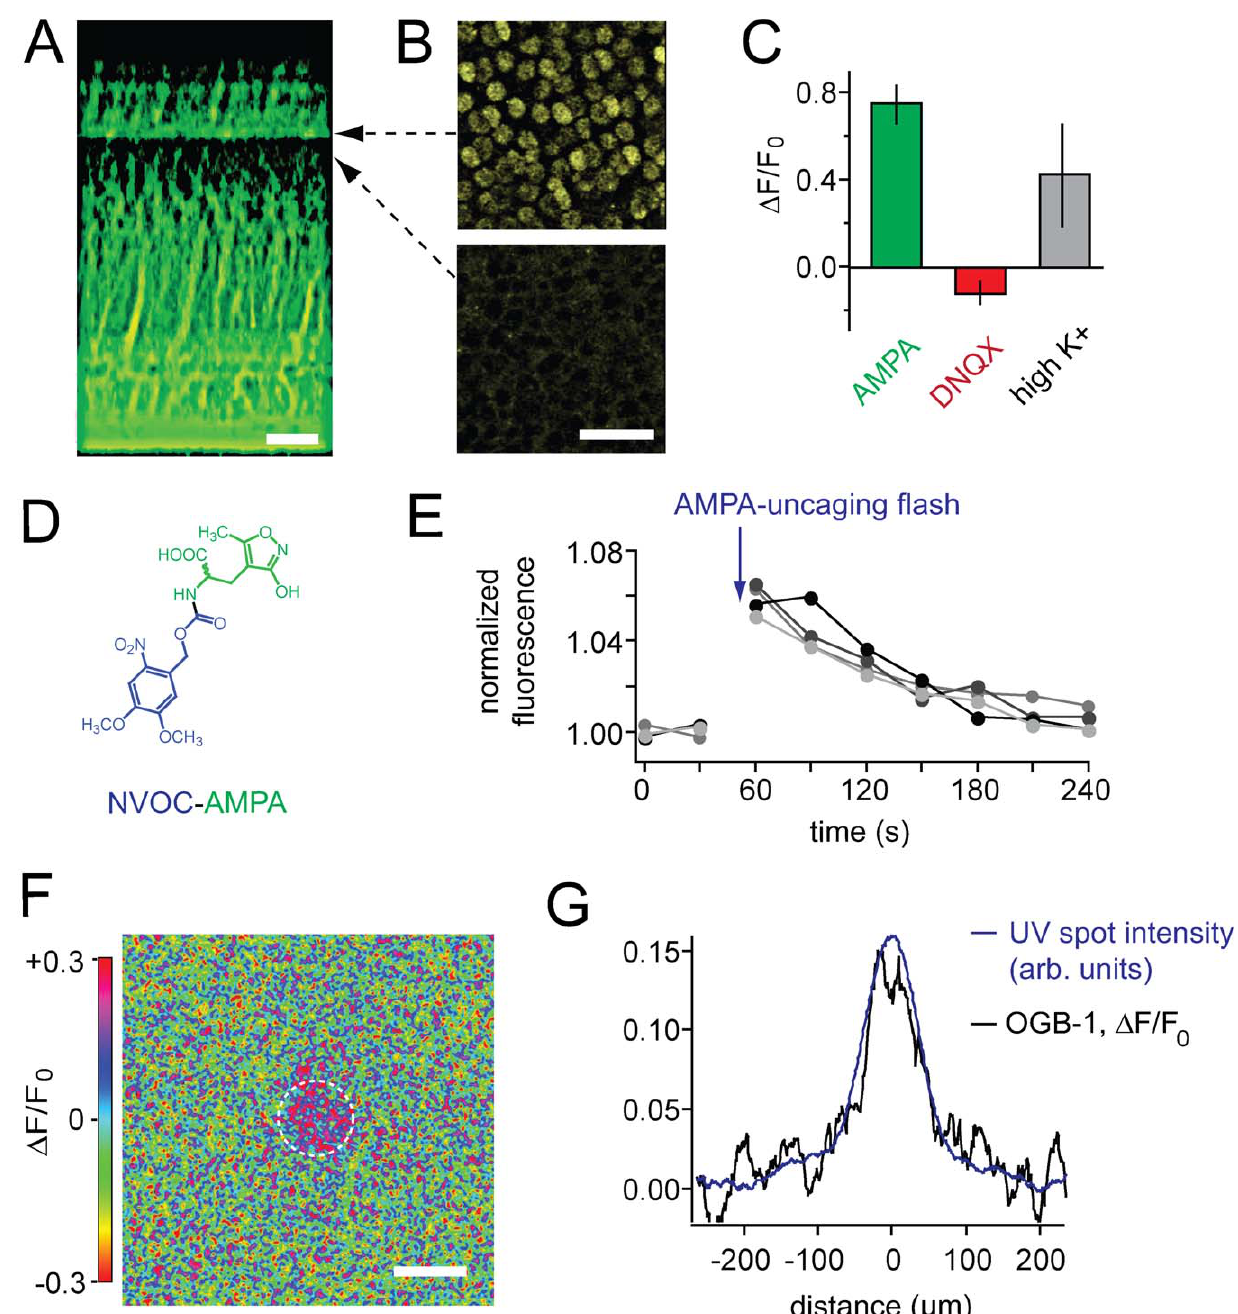
Figure 5. AMPA triggers a rise in Ca 2 + in the cone synaptic terminal. Incubating anole retina with 100 m M of the AM-ester form of Oregon Green BAPTA-1 (OGB) resulted in robust loading of Ca 2 + indicator dye into cone terminals. (A) A ‘‘virtual slice’’ of a flat-mounted retina loaded with OGB, rendered using a z-stack of 80 cross-sectional images. Images were taken at 2 m m intervals through the entire retina using a 2-photon microscope. Labeling is selective for photoreceptors (top) and retinal ganglion cells and Muller glial cells (bottom). (B) Representative cross-sectional images of OGB fluorescence in a flat-mounted retina. Cone terminals (top) are brightly labeled, while the region of the INL immediately below the cone terminals is not (scale bar = 20 m m, A,B). (C) Average peak OGB-1 fluorescence change caused by AMPA ( n =5), DNQX ( n =4), and high K + ( n =5). (D) NVOC-AMPA, a photolyzable agonist for selective optical activation of AMPA receptors. (E) Four uncaging trials from an OGB-1-loaded retina show that uncaging NVOC-AMPA (50 m M) with UV light triggers rapid, reversible increases in cone terminal Ca 2 + . (F) OGB-1 fluorescence increase in a flat-mounted retina triggered by flash uncaging of NVOC-AMPA. The dotted circle represents the full-width half-maximal of the Guassian region of uncaging. Scale bar = 100 m m. (G) Profile of the OGB-1 fluorescence increase in a flat-mounted retina and of the UV uncaging spot.